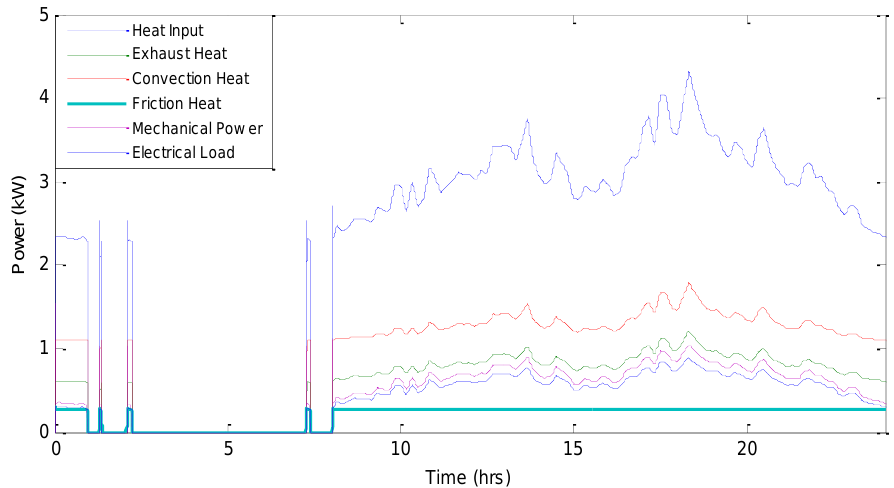
Figure 6. Simulated power component distribution vs. time as predicted by the engine model.